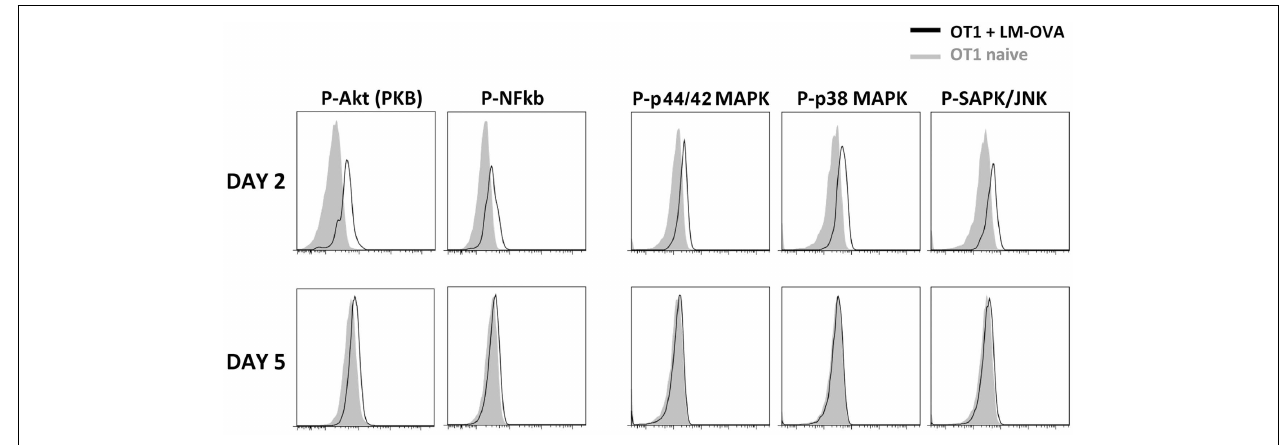
expression of phosphorylated signal transduction molecules in CD90.2 + CD45.1 + CD8 + Tg cells at different time points after priming.The labeling with isotype controls is shown in